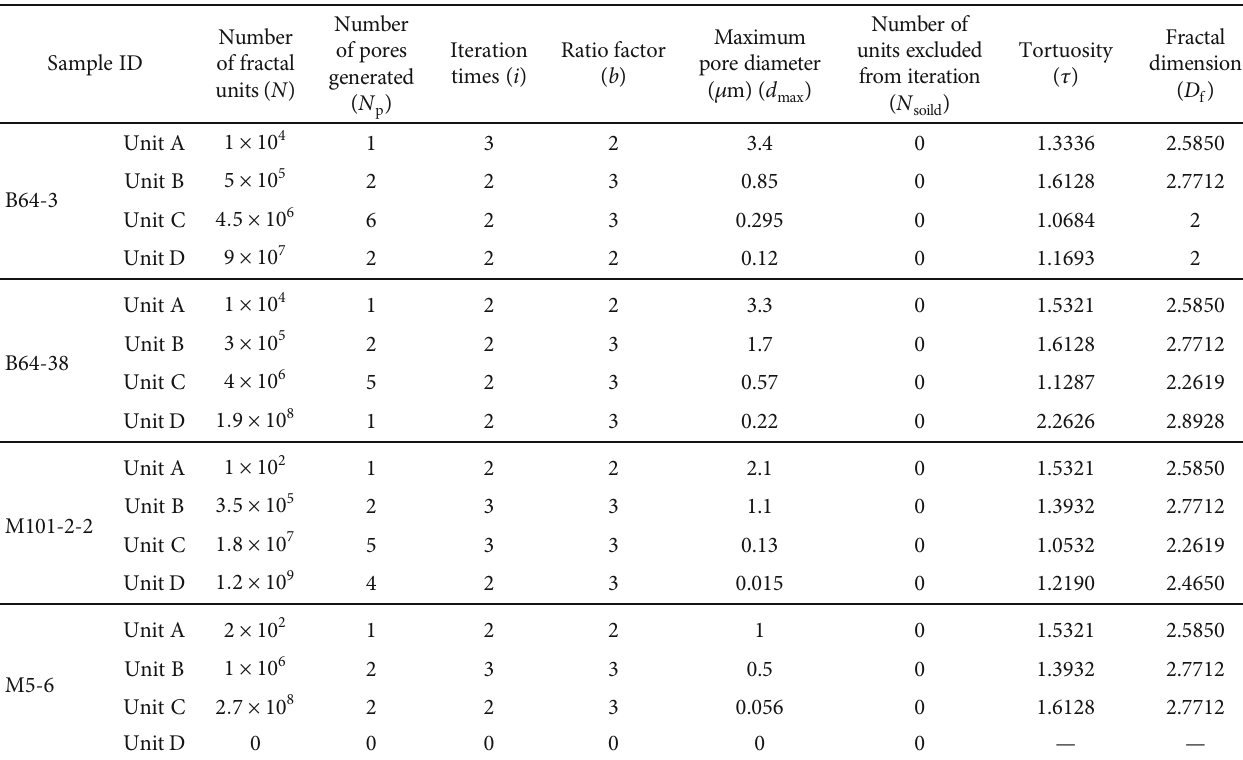
Table 1: Parameters of the IFU models of some typical